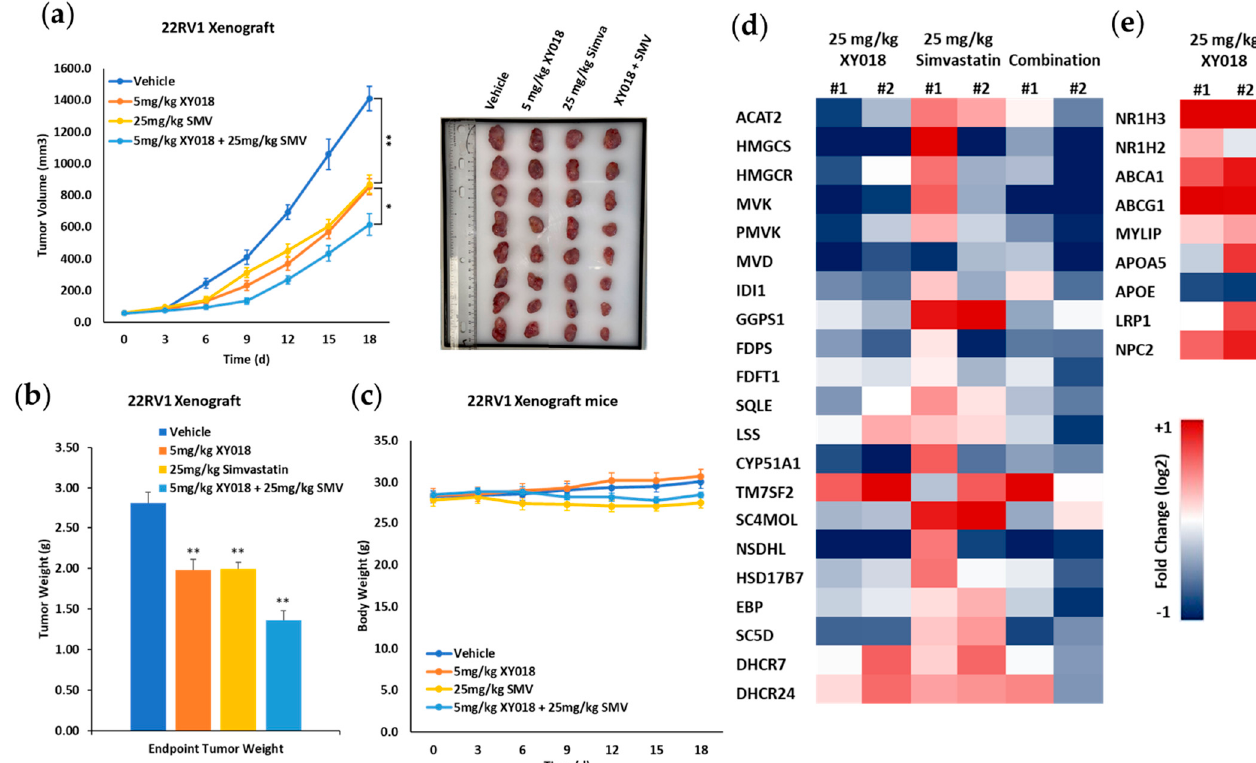
Figure 6. ROR γ antagonist in combination with statin inhibit mCRPC tumor growth. ( a ) Growth inhibition effect of the indicated treatments (XY018, 5 mg/kg i.p. daily; SMV, 25 mg/kg orally daily; the combination of the two treatments; or vehicle) on 22Rv1 xenograft tumors ( n = 7 mice per group). Representative images are shown. ( b ) 22Rv1 xenograft tumors were dissected and weighed at the end point of growth inhibition experiments from ( a ). ( c ) Mice bearing the xenograft tumors were weighed at the end point of the growth inhibition experiments from ( a ). ( d , e ) Heat maps of mRNA expression changes in 21 cholesterol biosynthesis genes ( d ) and 9 cholesterol efflux genes ( e ) as measured by qRT ‐ PCR in the xenograft tumors treated with XY018 (25 mg/kg i.p. daily), SMV (25 mg/kg orally, daily), or XY018 + SMV combination for 7 d, as compared to vehicle. Data are shown as mean ± s.d. Student’s t test. * p < 0.05 ** p < 0.01.